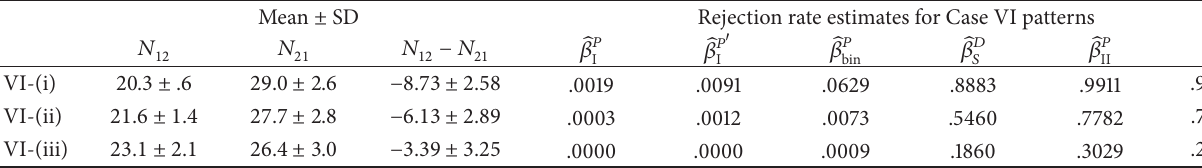
Table 12: The means ( ± SD) of the off-diagonal entries, 𝑁 12 , 𝑁 21 , and their difference 𝑁 12 − 𝑁 21 and the rejection rate estimates for Case VI = 10000 , 𝑚 = 20 , 𝑚 = 10 (hence 𝑛 = 𝑛 = 40 ) at 𝛼 = .05 . Column labeling is as in Table 6. patterns with 𝑁 1 2 1 2 mc